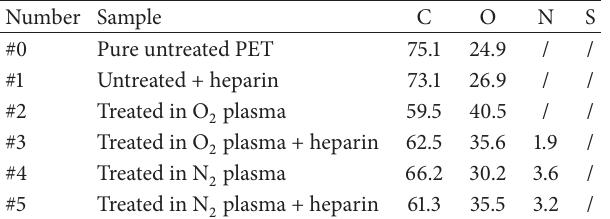
Table 1: XPS surface composition of PET samples coated with heparin (in at.%).